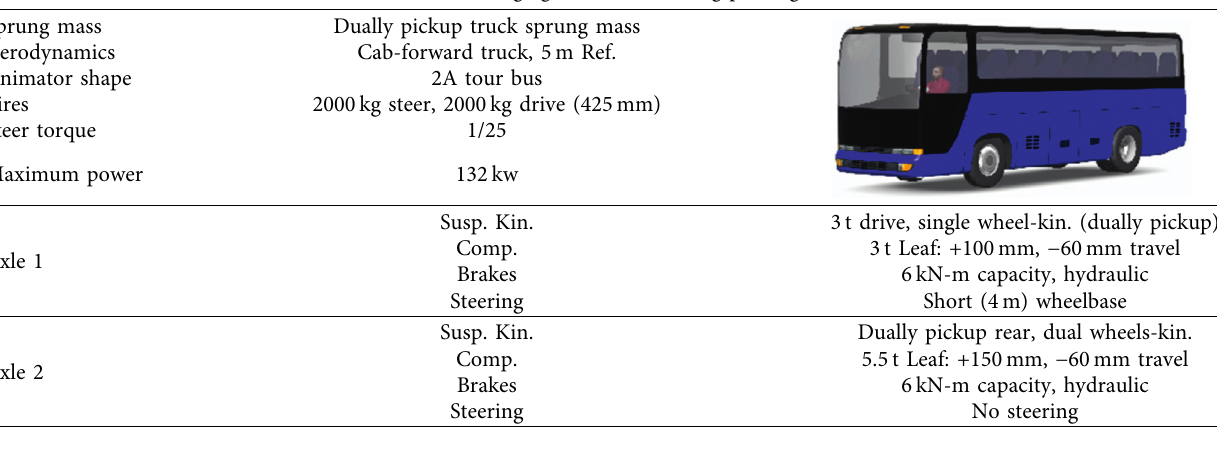
Table 4: Model of large gasoline consuming passenger vehicle.